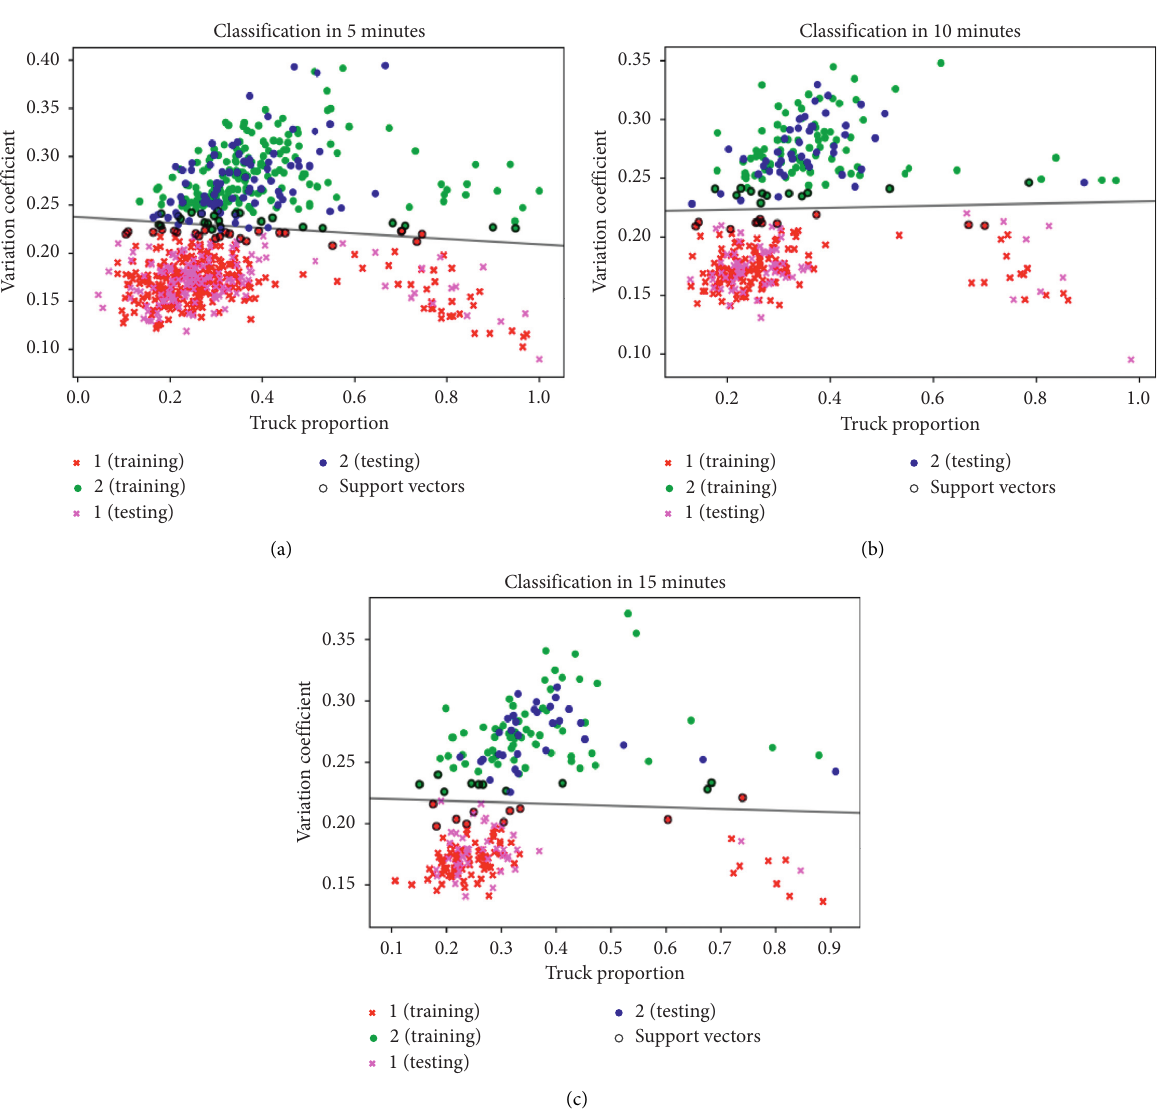
Figure 4: Classification diagram of the support vector machine of the speed variation